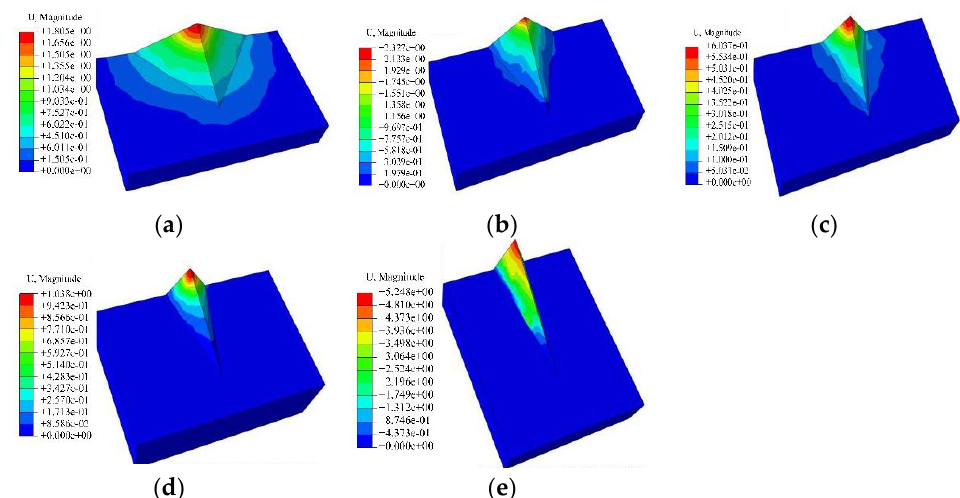
Figure 8. Ridge slope displacement cloud under different flank inclination angles (unit: m); ( a ) β = 30 ◦ ; ( b ) β = 40 ◦ ; ( c ) β = 50 ◦ ; ( d ) β = 60 ◦ ; ( e ) β = 70 ◦ .